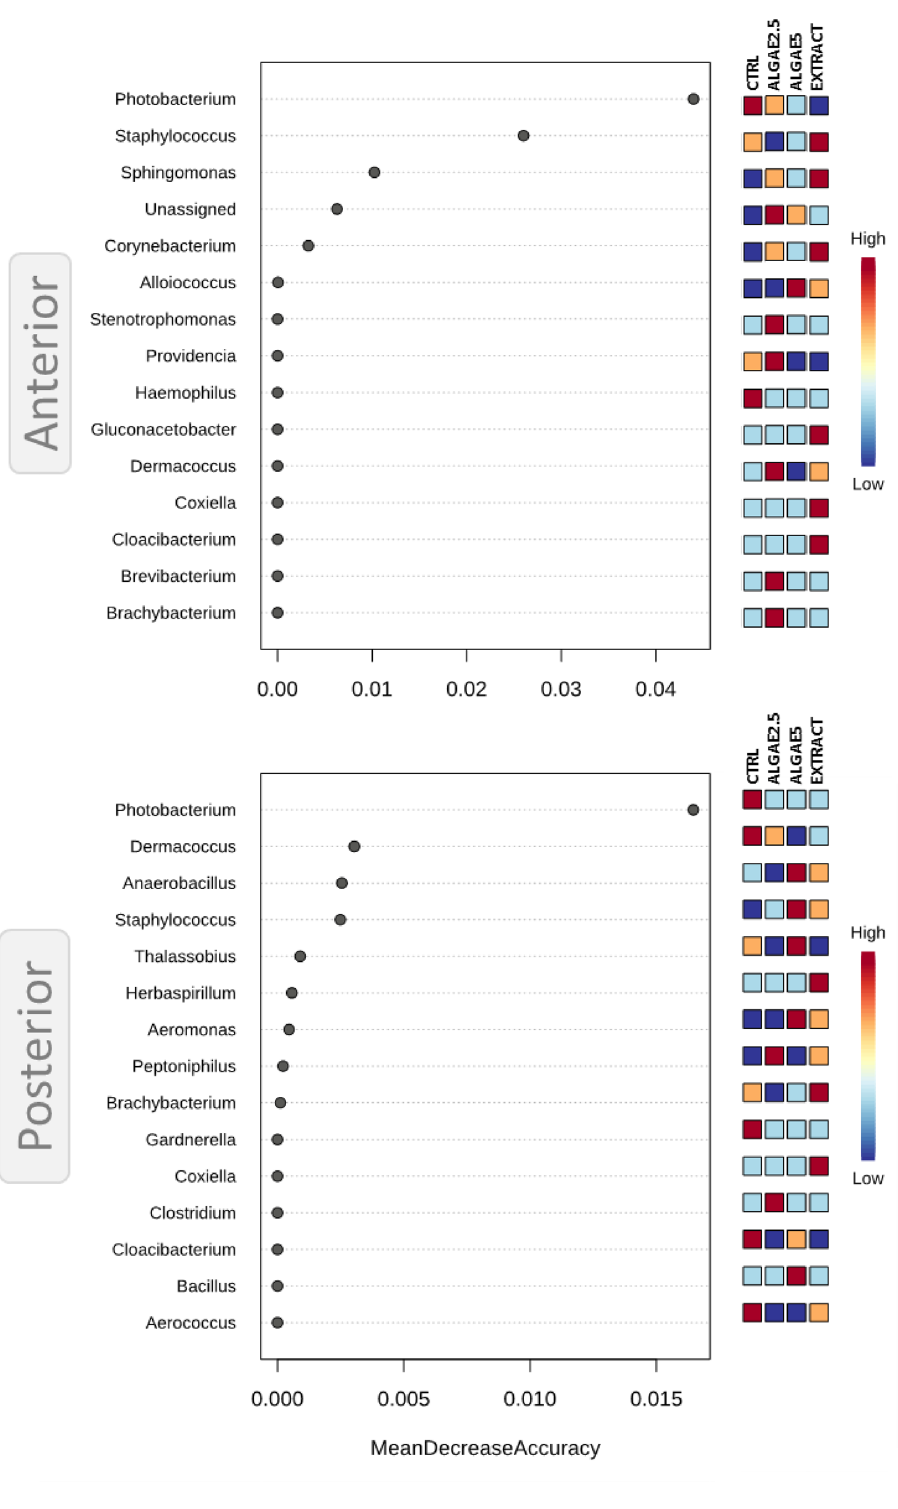
Figure 6. Identification of significant features on the European seabass gut microbial community when fed different diets. Analysis was based on Random Forest analysis and plot (left side) represents important features for the respective intestine section, whereas mini heatmap (right side) shows the pattern of change across different groups. Fish were fed a basal diet with no supplement (CTRL) or supplemented with Gracilaria gracilis powdered biomass at 2.5% (ALGAE2.5), at 5% (ALGAE5) or with the seaweed extract at 0.35% inclusion rate